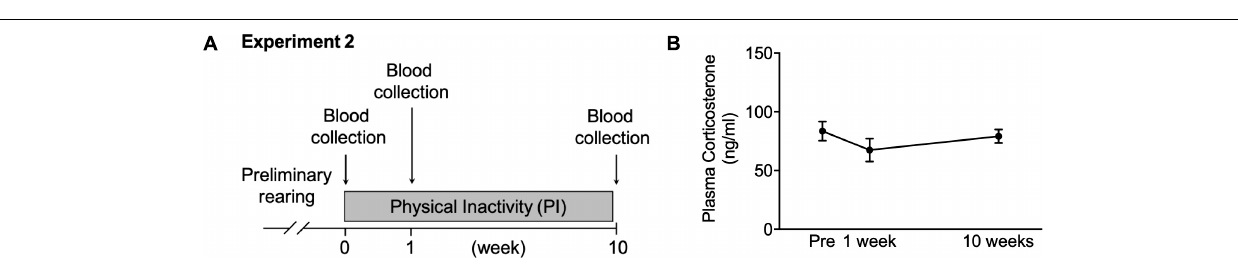
FIGURE 3 | Changes in plasma corticosterone concentration during housing in the PI cage. (A) Schedule for collecting blood during housing in the PI cage. (B) Plasma corticosterone concentration before housing and at 1st and 10th weeks. All data are presented as the mean ± SEM ( n = 10). Data were analyzed using one-way ANOVA with Dunnett’s post-hoc